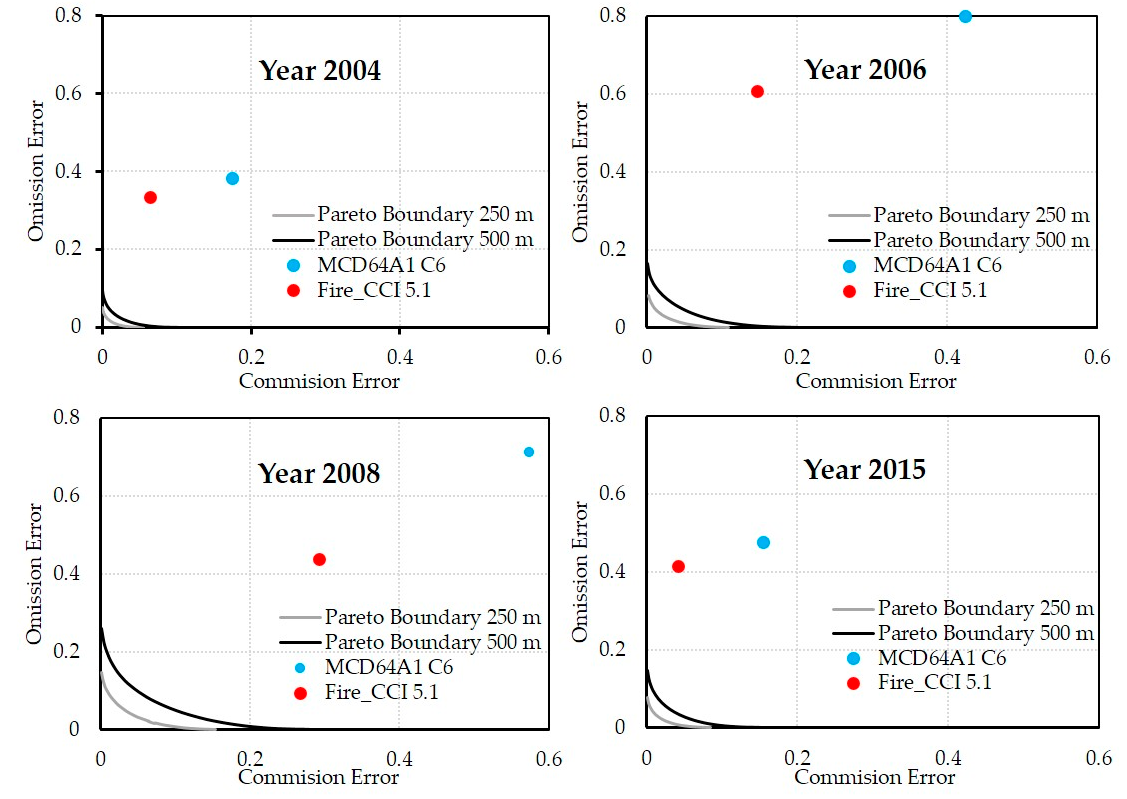
Figure 11. Pareto boundaries at 250 and 500 m and annual CE and OE for the MCD64A1 and Fire_CCI 5.1 products for 2004, 2006, 2008 and 2015.